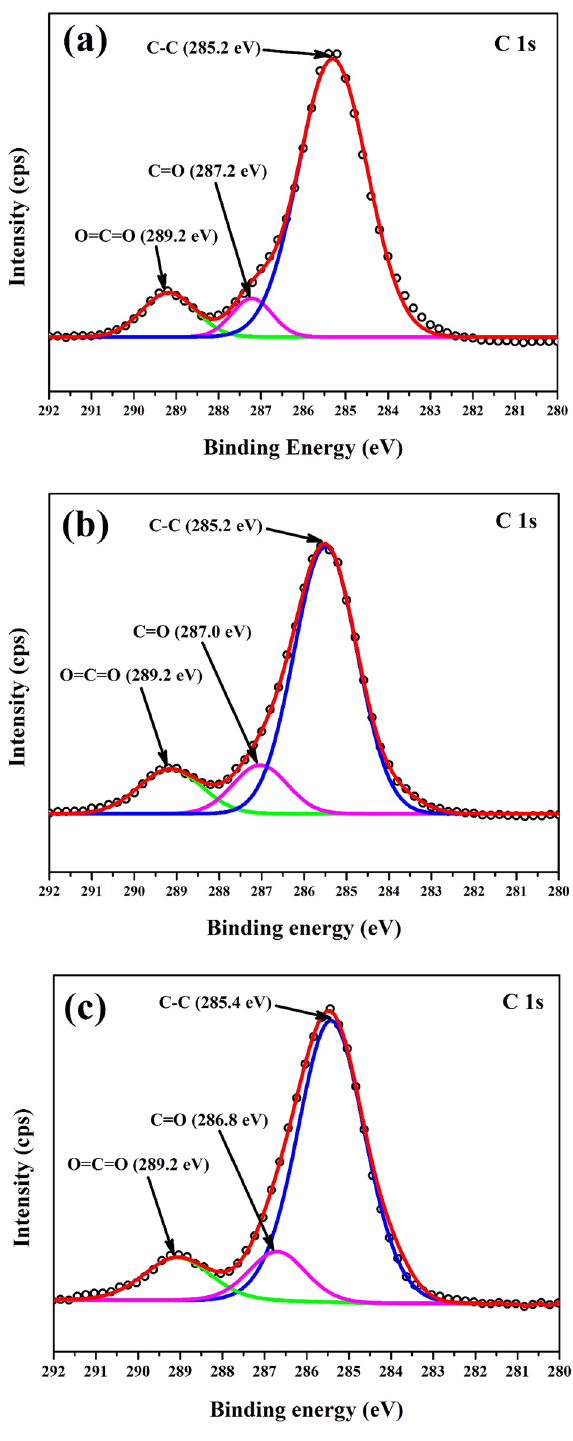
Figure 5. XPS spectra of C 1 s for ( a ) LA, ( b ) LAPC-1 and ( c )